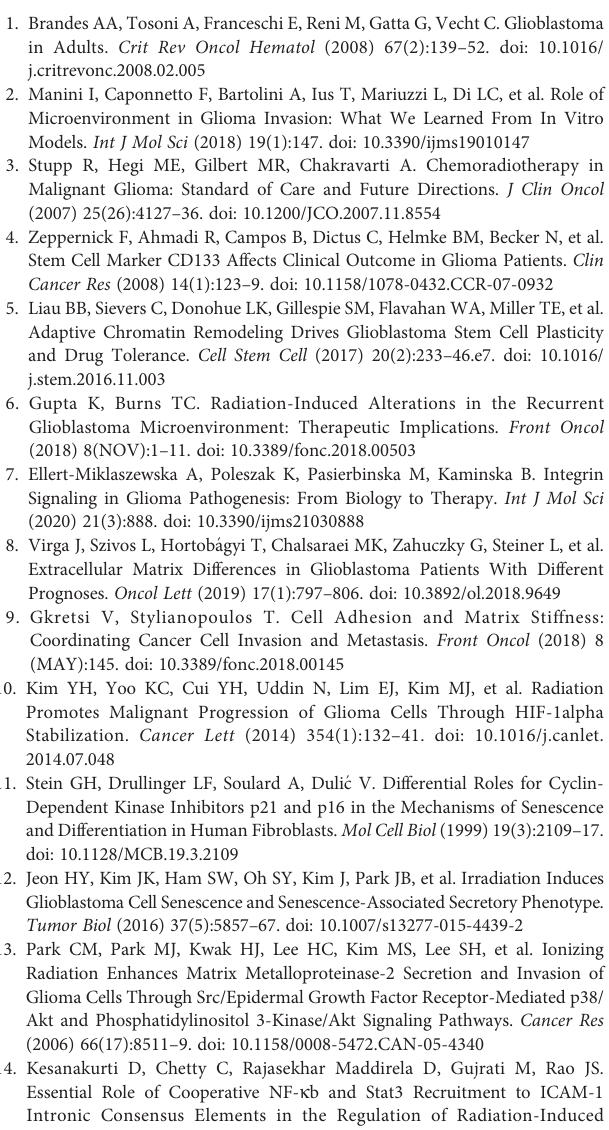
Supplementary Table 4 | Number of receptors, ligands and pair of ligand- receptors upregulated in each GBM cell line. The receptors and ligands were considered upregulated when padj ≤ 0.0001 and log fold change > 2. Supplementary Table 5 | Correlation between de-regulated genes from different categories and MKI67 expression. Data were obtained from the cbioportal.org website. Spearman ’ s Correlation > 0.5 was used as a